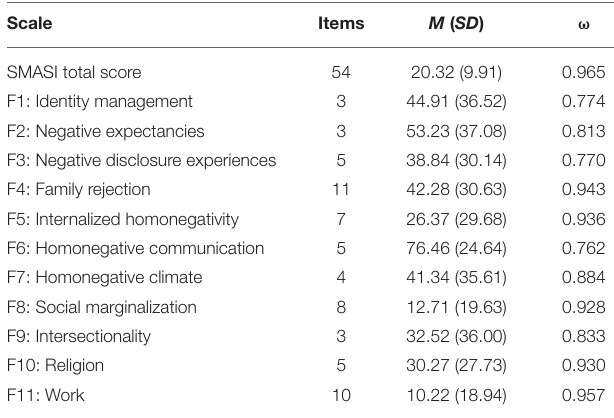
TABLE 2 | Means, standard deviations, and reliabilities ( ω ) of SMASI total score and subscale scores.